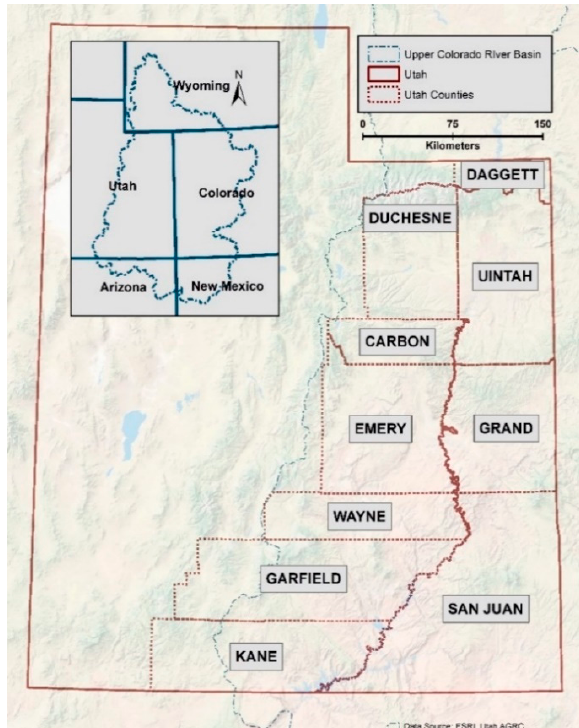
Figure 1. Utah counties in Upper Colorado River Basin (UCRB).